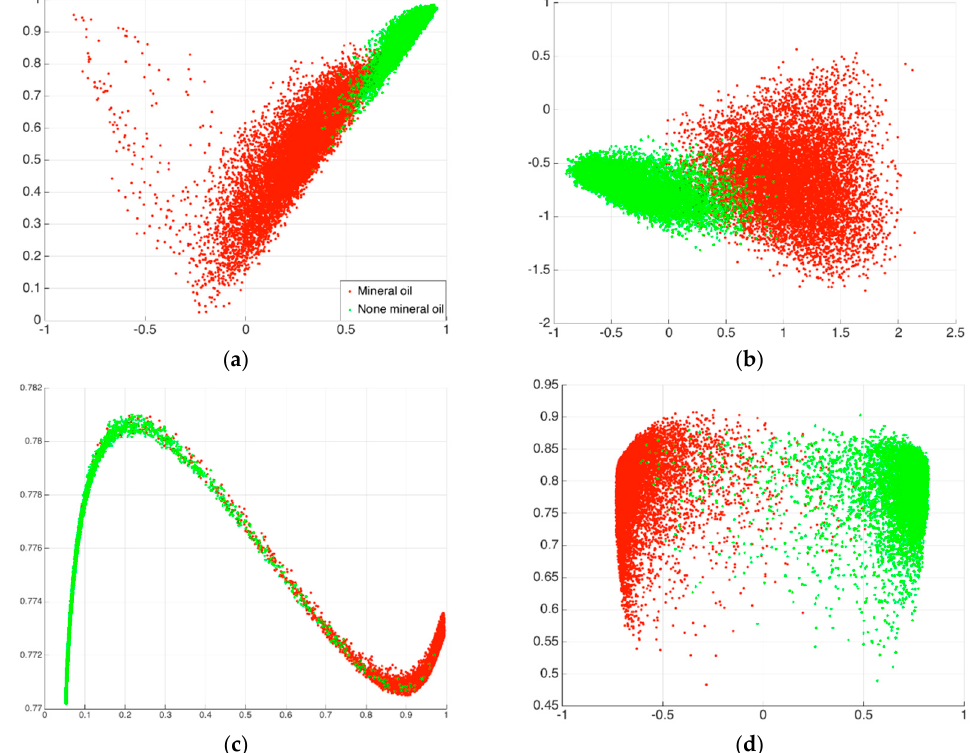
Figure 6. Scatter plots of the main original features ( a ) and the features derived by principal component analysis (PCA), deep believe network (DBN) and stacked autoencoder (SAE) ( b – d ). Table 6. Testing error (1-accuracy) of classification achieved by different classifiers and on different sizes of data samples.